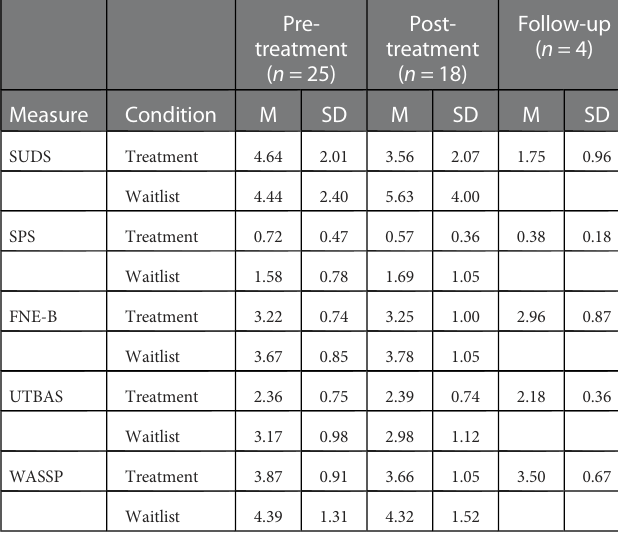
TABLE 2 Descriptive statistics for self-report